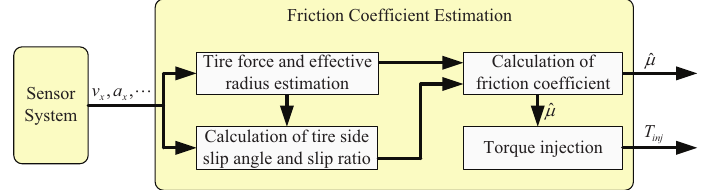
Figure 2. Structure of the friction coefficient estimation